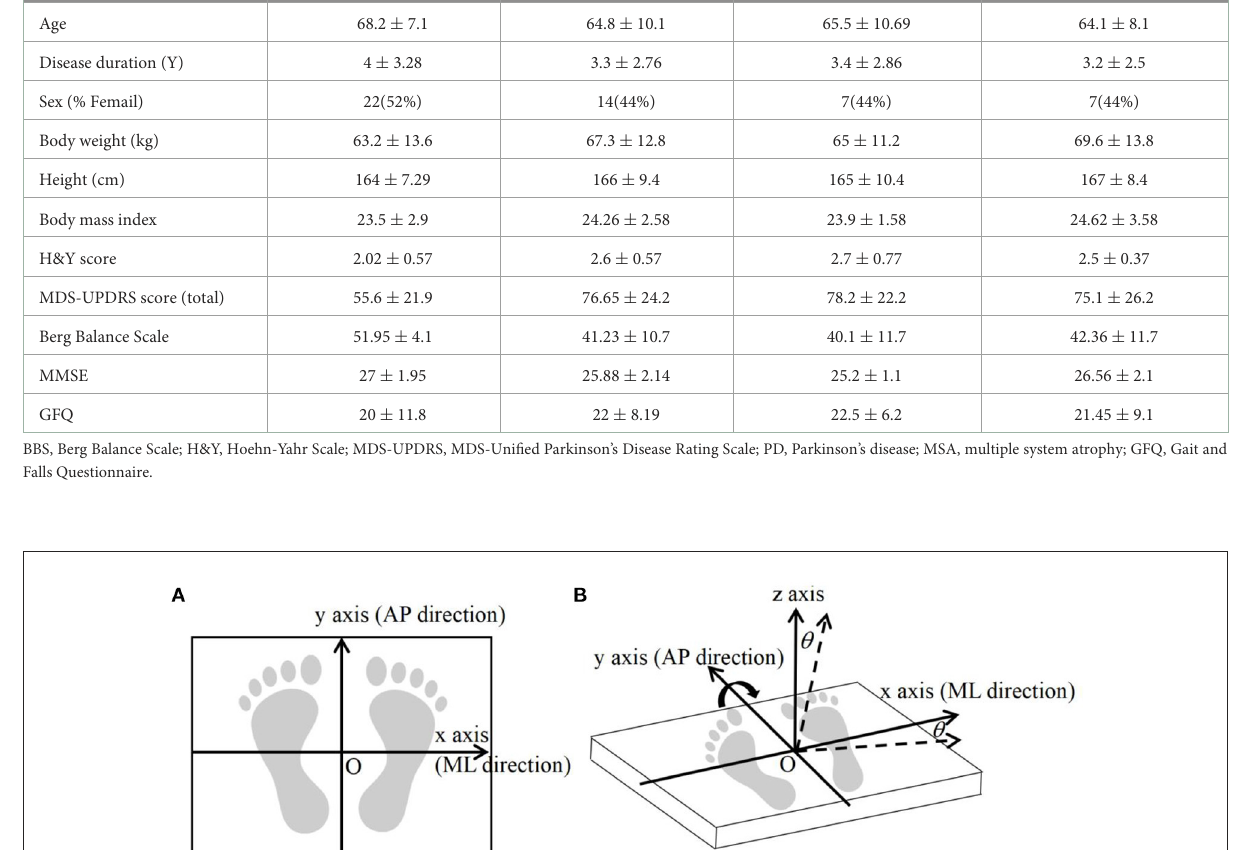
COP signal was the central position of the force plate. Since